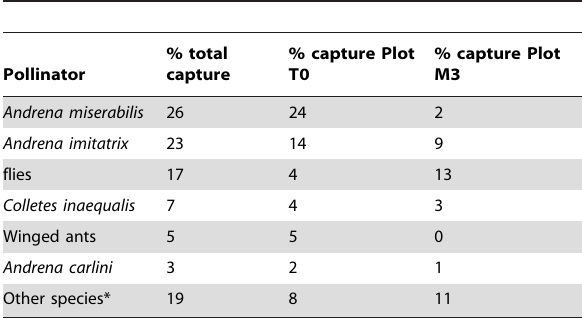
Table 4. Native and naturalized insect pollinators in GE plum trees (Plot T0) and non-GE trees (Plot M3).